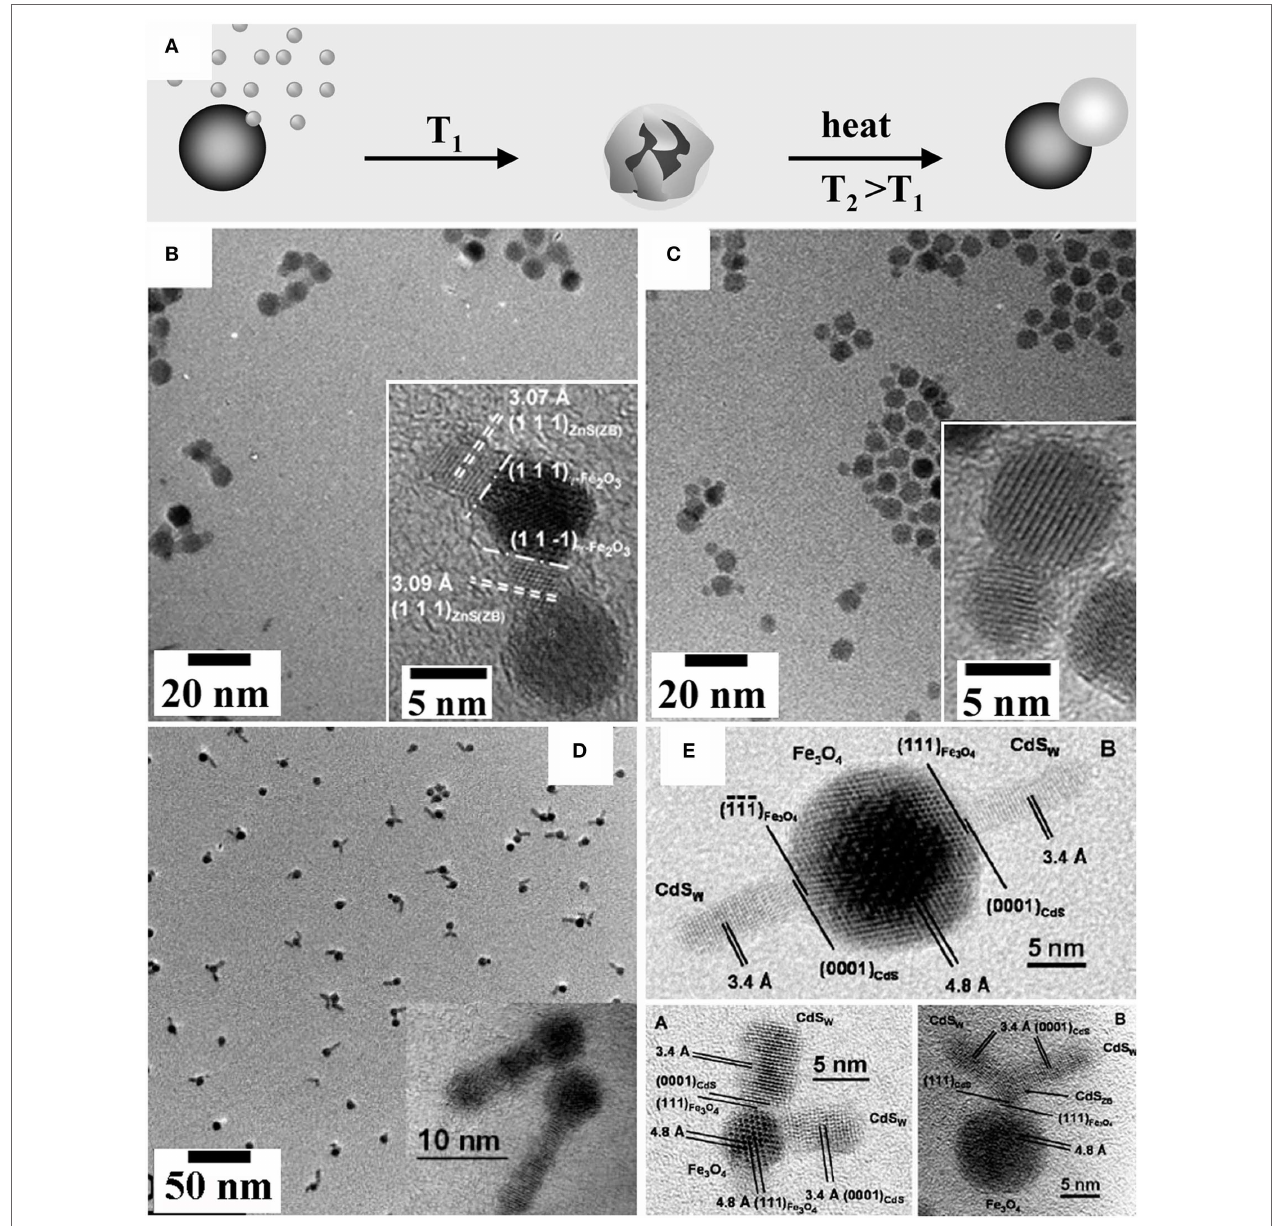
FIGURE 3 | Examples of heterocluster magnetic heterostructured nanocrystals (MHNCs) synthesized by post-deposition crystallization, coalescence, and dewetting . (A) Sketch of the mechanism [adapted from Casavola et al. (2008) with permission, copyright Wiley-VCH Verlag GmbH & Co. KGaA]. (B–E) Low-magnification transmission electron microscopy galleries and selected high-resolution transmission electron microscopy images of: (B,C) Fe 3 O 4 –ZnS hetero-dimers and hetero-oligomer MHNCs [adapted from Kwon and Shim (2005) with permission, copyright American Chemical Society]; (D,E) Fe 3 O 4 –CdS anisotropic MHNCs with one or multiple rod-shaped CdS sections departing from a single spherical Fe 3 O 4 seed [reproduced from McDaniel and Shim (2009) with permission, copyright American Chemical